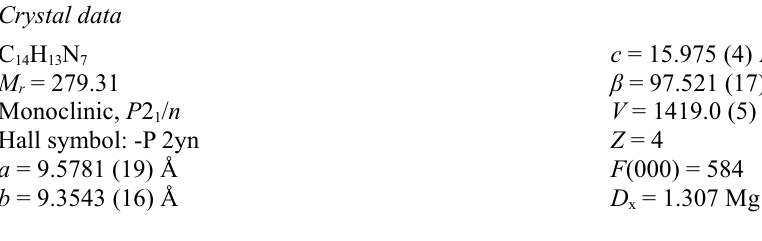
Intermolecular C—H···\p interaction between one aromatic pyrimidine ring and adjacent molecule. 1-(2-Pyridyl)-N,N ′